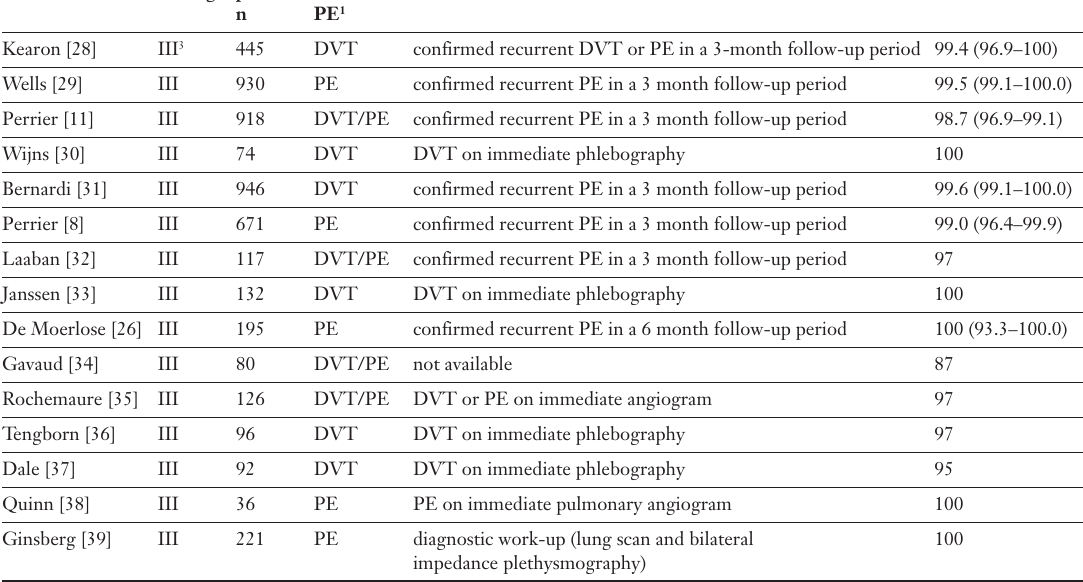
Results of prospec- tive studies on the assessment of D-dimer ELISA performance in the emergency depart- ment for patients with suspected venous thromboem-